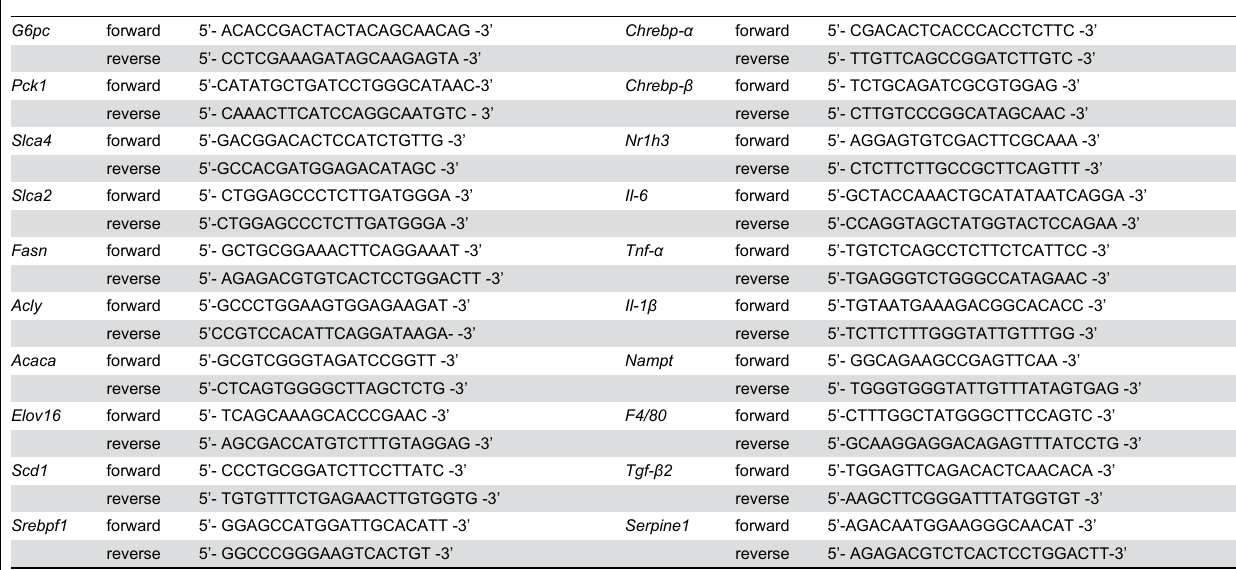
Table 1. PCR primer sequences for real-time PCR analysis.